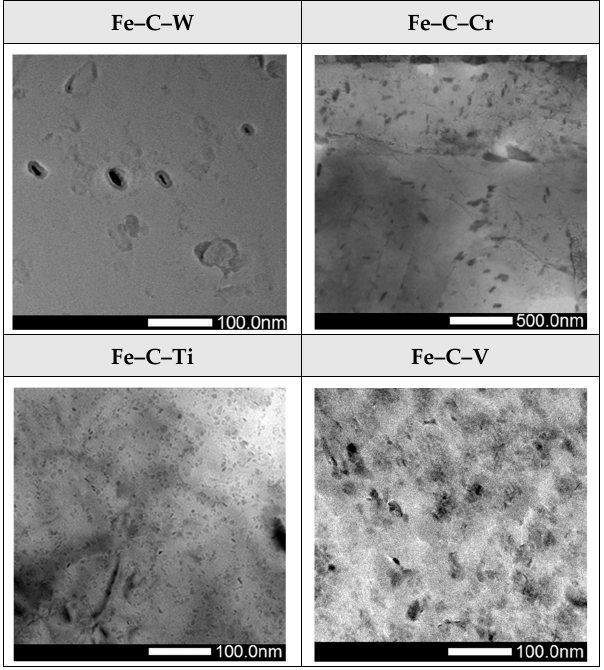
Figure 2. TEM images of the different alloys.